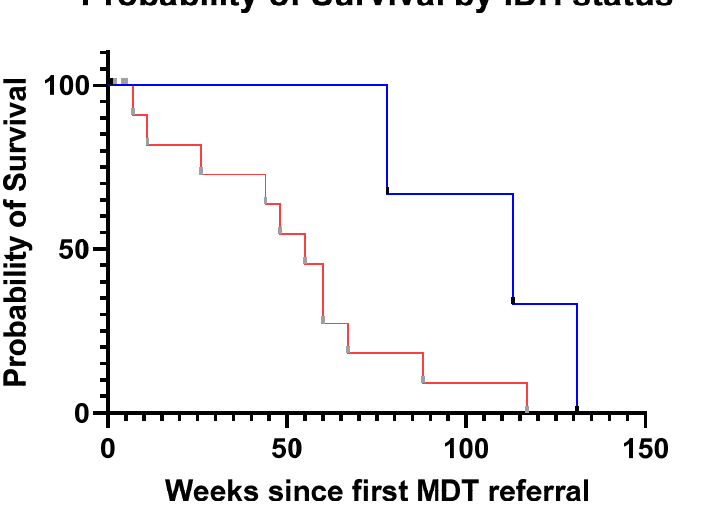
Figure 3. Survival analysis. Kaplan–Meier estimate of length of survival of individual patients in weeks from the date of their first MDT referral. The patients are grouped by IDH status, where known (n = 20). Where no date of death was available, the data were censored at the last known time of contact with our service.